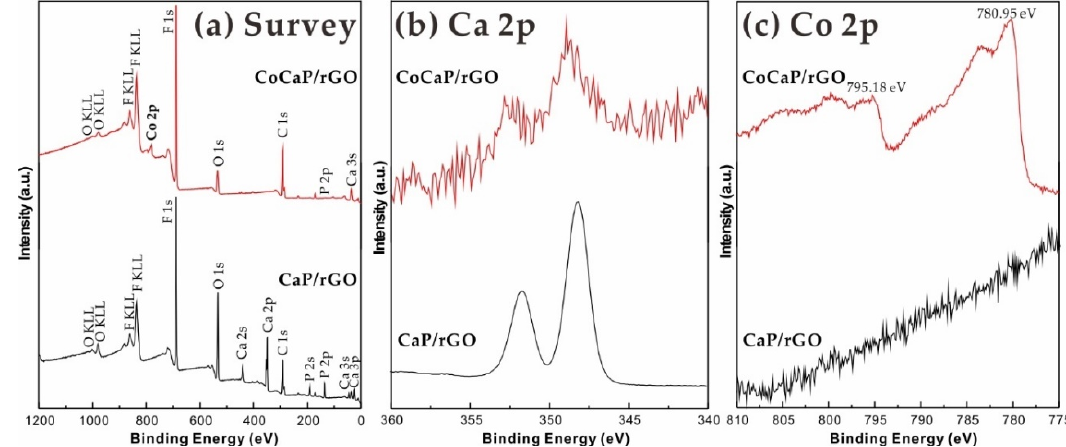
Figure 3. XPS spectrum of ( a ) Survey, ( b ) Ca 2p and ( c ) Co 2p of CaP/rGO and CoCaP/rGO. (Fluorine signal originated from Nafion.)